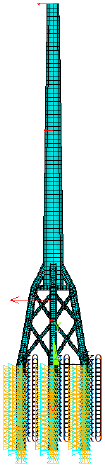
Figure 3. An FE model of the jacket.